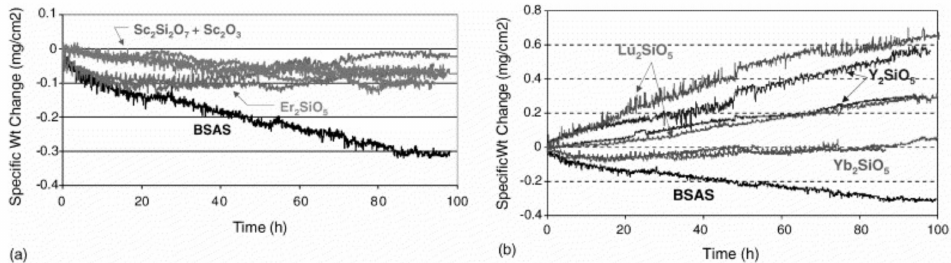
Figure 11. Volatility of hot-pressed rare earth silicates exposed to 50 vol.% H 2 O-balance O 2 flowing at 4.4 cm/s at 1500 ◦ C and 1 atm total pressure [45]. ( a ) weight change versus time for rare earth Sc 2 Si 2 O 7 + Sc 2 O 3 , Er 2 SiO 5 and BSAS; and ( b ). weight change versus time for rare earth Lu 2 SiO 5 , Y 2 SiO 5 , Yb 2 SiO 5 and